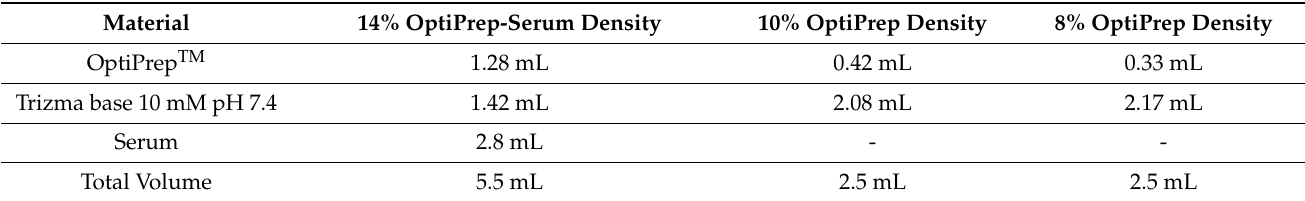
Table 2. OptiPrep